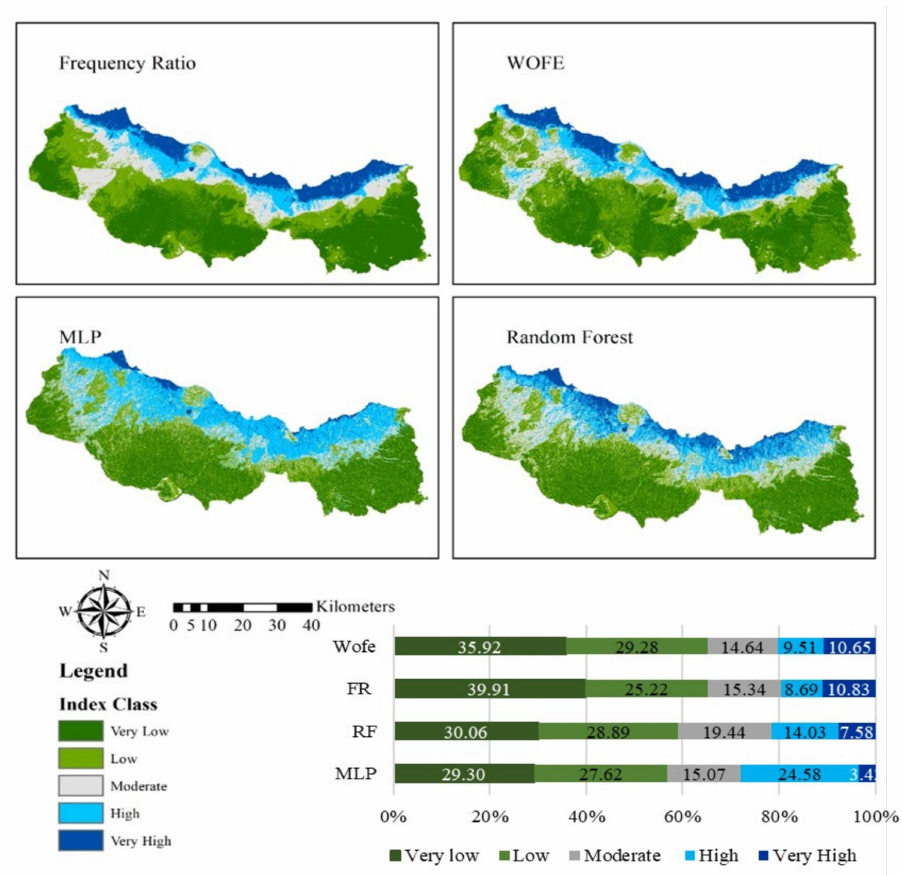
Figure 8. Flood susceptibility map obtained using FR, WofE, RF, and MLP